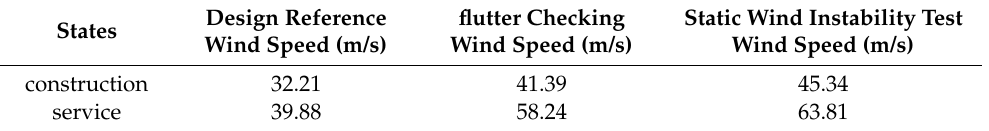
Table 1. Basic wind parameters.